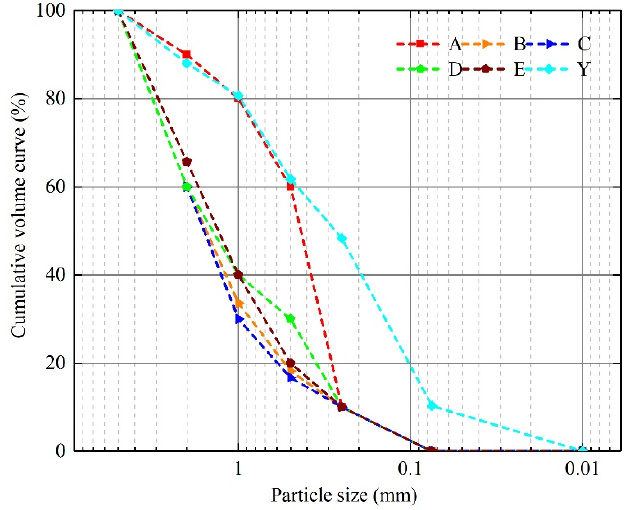
Figure 1. Particle-accumulated curve of calcareous sand with different gradations.